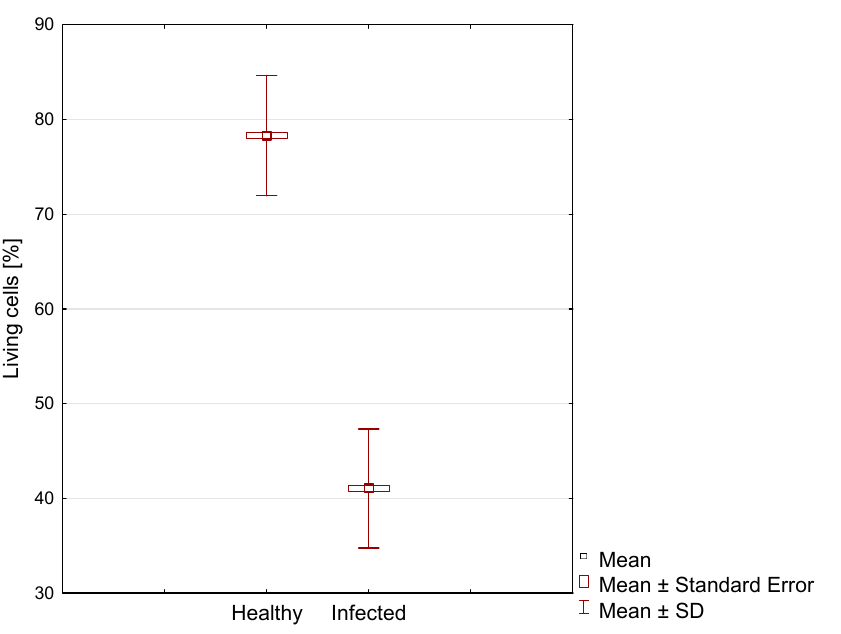
Figure 3. Average values of the number of living cells with marked standard errors and standard deviation for the tested cases of healthy and infected bees.